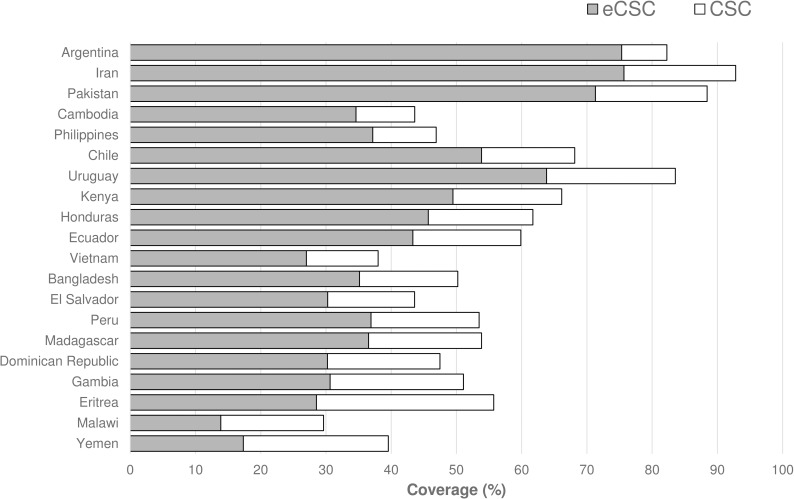
Cataract surgical coverage (CSC) and effective cataract surgical coverage (eCSC; persons <6/60, %) in 20 countries, 2005–2013.Arranged in ascending order of relative gap between CSC and eCSC (i.e. 1 –eCSC / CSC); the gap is smallest for Argentina and largest for Yemen.